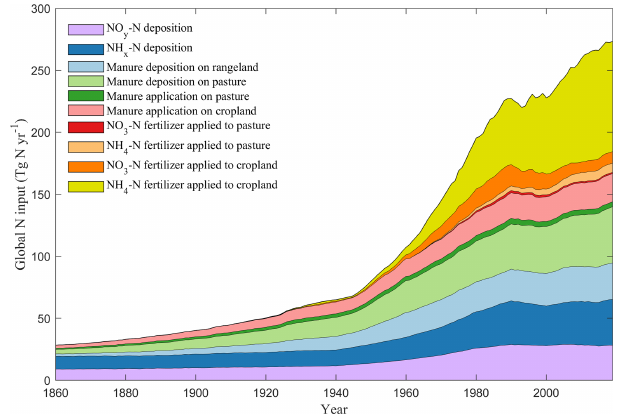
Figure 4. Long-term trends in anthropogenic nitrogen inputs to ter- restrial ecosystems during the period from 1860 to 2019. N input to global terrestrial ecosystems stems from three major categories: N fertilizer, manure N, and N deposition. These categories are further divided into 10 specific types: NH + -N fertilizer applied to cropland, 4 NO − -N fertilizer applied to cropland, NH + -N fertilizer applied to 3 4 pasture, NO − -N fertilizer applied to pasture, manure N application 3 on cropland, manure N application on pasture, manure N deposition on pasture, manure N deposition on rangeland, NH x -N deposition, and NO y -N